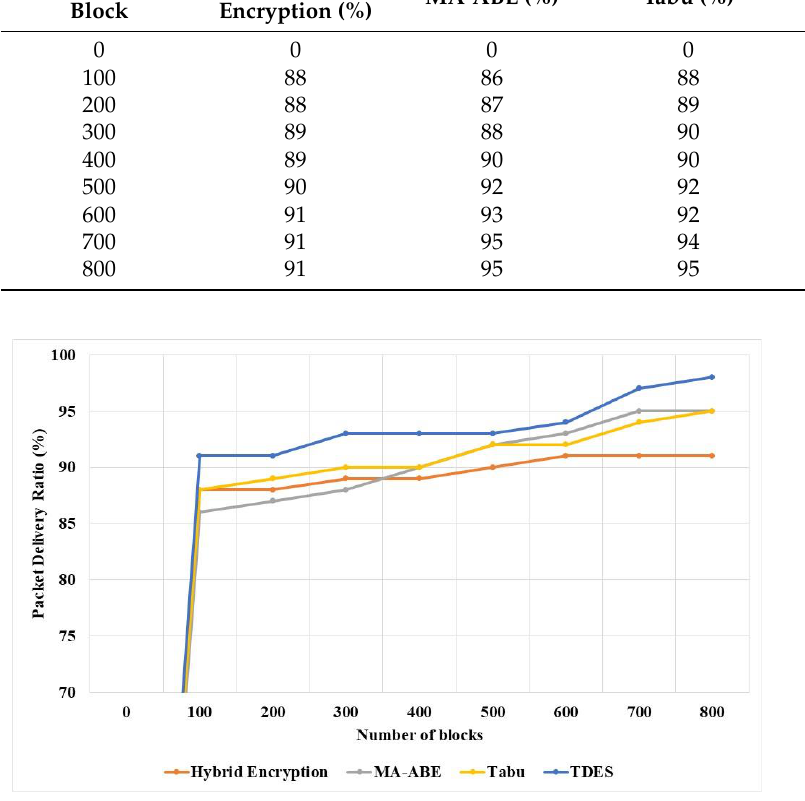
Figure 12. Packet delivery ratio of TDES and existing techniques for various numbers of blocks.